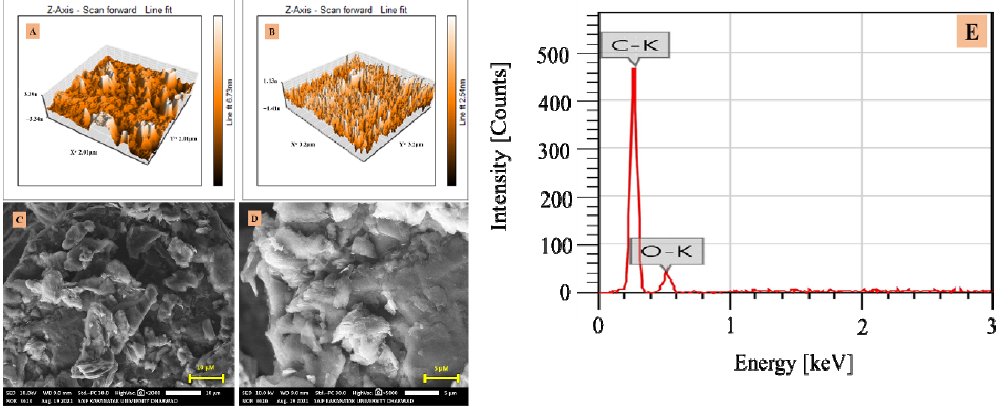
Figure 1. AFM image of ( A ) CPE and ( B ) G-CPE, ( C ) and ( D ) SEM images of G-CPE, and ( E ) EDS image of G-CPE.